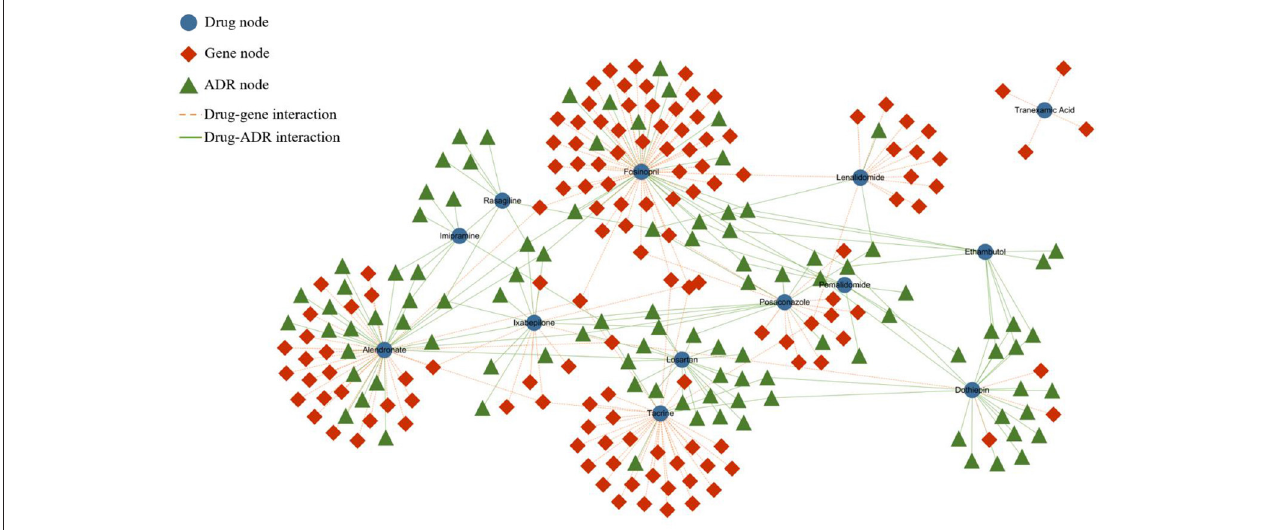
FIGURE 1 | Partial heterogeneous drug–gene–ADR network. To make the network clearer and more intuitive, we visualized the network by extracting some data from the entire dataset. The blue rounded nodes represent drugs, the red rhombic nodes represent genes, and the green triangular nodes represent side effects.